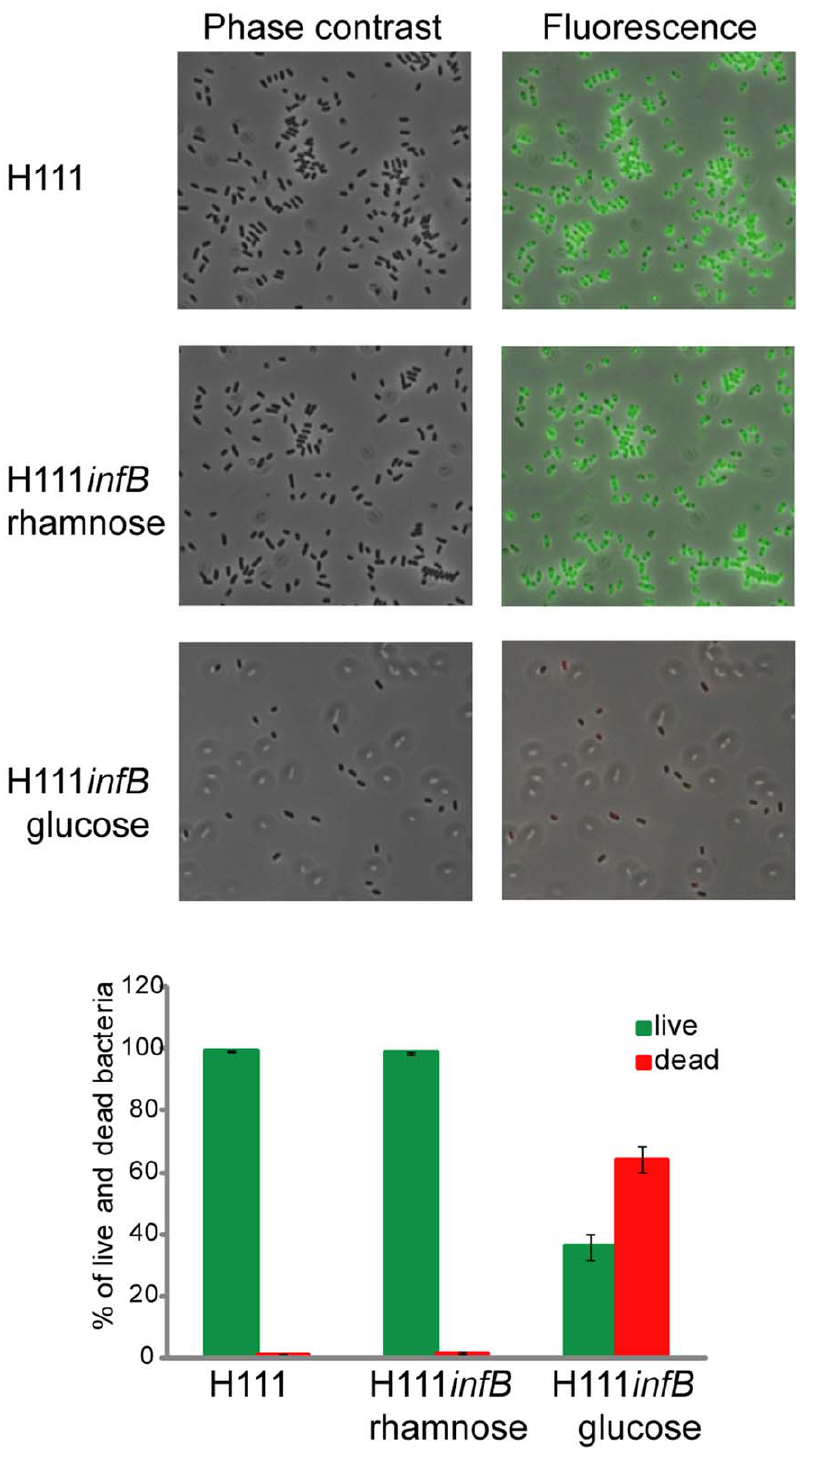
Figure 4. Microscopy and live-dead staining. Live-dead staining of the wild type strain H111 and of the rhamnose-inducible mutant H111 infB grown in the presence of rhamnose or glucose. Green fluorescence indicates viable cells, while dead bacteria appear fluorescent red. The figure depicts the reduced ability of H111 infB to survive in the medium with glucose.